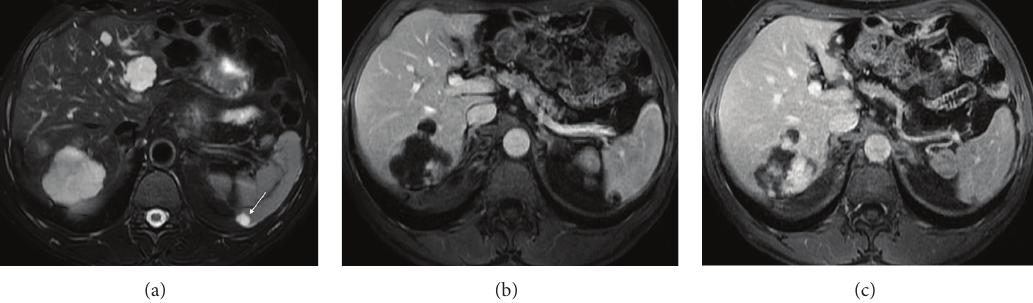
Figure 13: Splenic hemangioma. Axial T2wi FSE with fat suppression (a) and postcontrast axial 3D-GRE T1wi with fat suppression at the arterial (b) and interstitial (c) phases. The hemangioma is depicted as a well-defined, homogeneous, and hyperintense lesion on T2wi (arrow, (a)), with a peripheral enhancement with centripetal and delayed progression, on postcontrast images ((b) and (c)). Note the hepatic hemangiomas on the same imaging